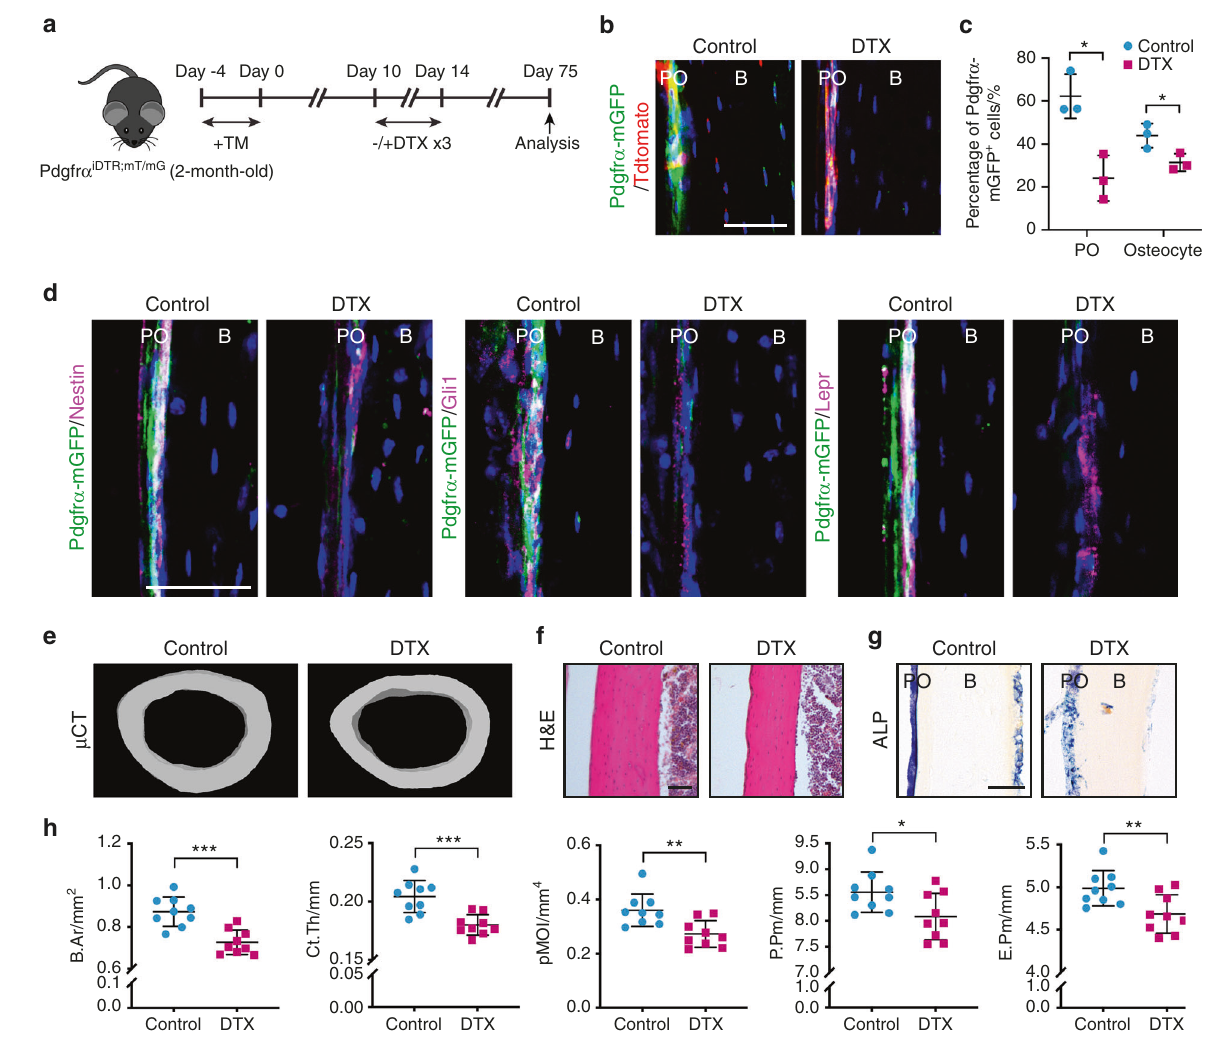
Fig. 3 Depletion of periosteal PDGFR α reporter + progenitor cells impairs cortical homeostasis. a PDGFR α iDTR;mT/mG animals (male, aged 2 mo) were sequentially administered tamoxifen (TM) and diphtheria toxin (DTX) and analyzed after 2 mo. b Representative images of PDGFR α reporter activity (GFP) among DTX- or control-treated PDGFR α iDTR;mT/mG animals. Nuclei, DAPI (4 ′ ,6-diamidino-2-phenylindole, blue). c Percentage of mGFP + periosteal cells/total periosteal cells and mGFP + osteocytes/total osteocytes. d Analysis of Nestin, Gli1, and LepR expression in DTX- or control-treated PDGFR α iDTR;mT/mG animals by immunohistochemistry. e Micro-CT reconstructions of cortical bone in the midshaft femur. f , g Representative histologic appearance of the midshaft femur cortical bone observed by H&E ( f ) and alkaline phosphatase (ALP) staining ( g ). h Quantitative micro-CT analysis of the cortical bone in the control- and DTX-treated PDGFR α iDTR;mT/mG animals at the femoral midshaft. The analysis included the bone area (B.Ar), cortical thickness (Ct.Th), polar moment of inertia (pMOI), periosteal perimeter (P.Pm), and endosteal perimeter (E.Pm). Scale bars: 50 μ m. B bone, PO periosteum. The dot plots represent an individual animal, and the whisker plots indicate the mean and one-SD values. n = 3 animals per group ( b – d ) and 9 animals per group ( e – h ). * P < 0.05, ** P < 0.01, and *** P < 0.001, as assessed by two-tailed Student ’ s t